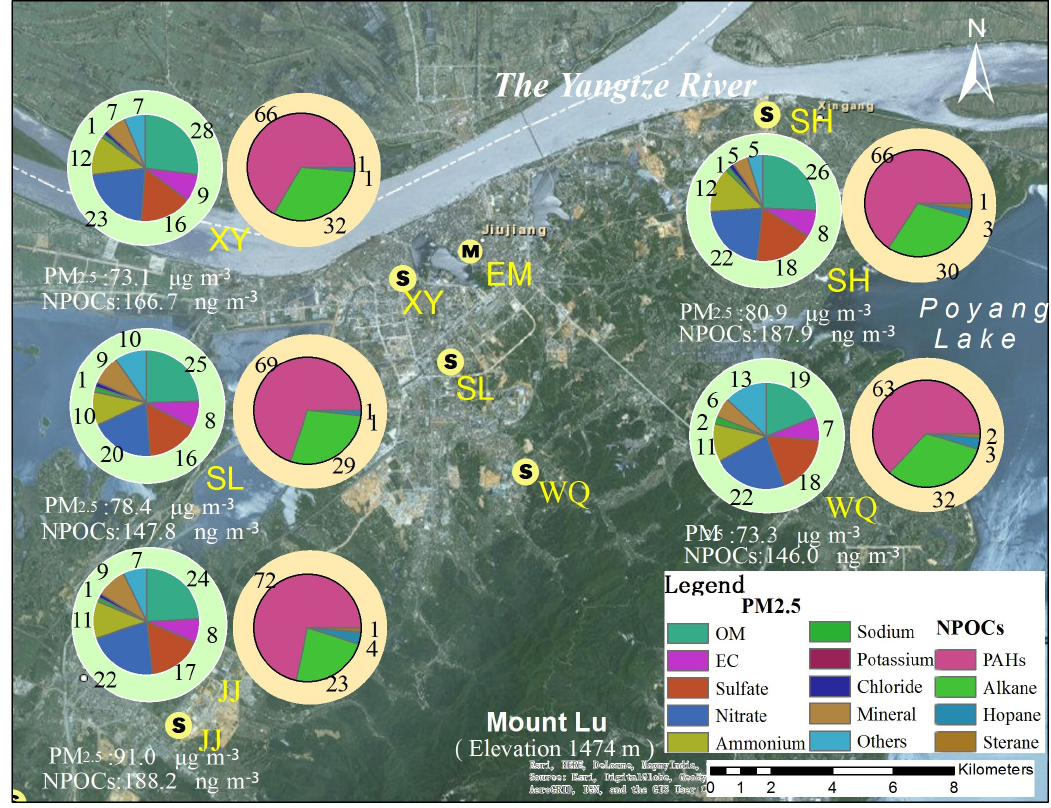
Figure 2. The percentiles of NPOCs and PM 2 . 5 constituents in five sampling sites in